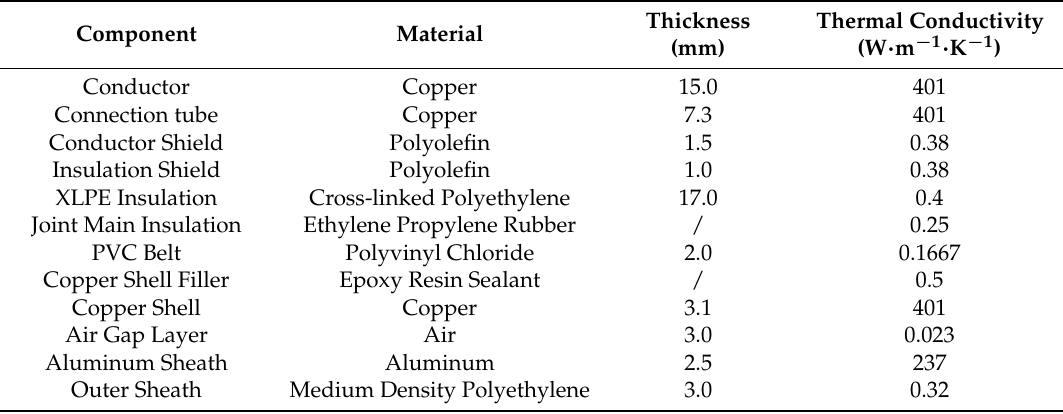
Figure 1. 2D axial model of the 110 kV prefabricated straight-through cable joint. Table 1. Detailed information of the prefabricated straight-through joint.